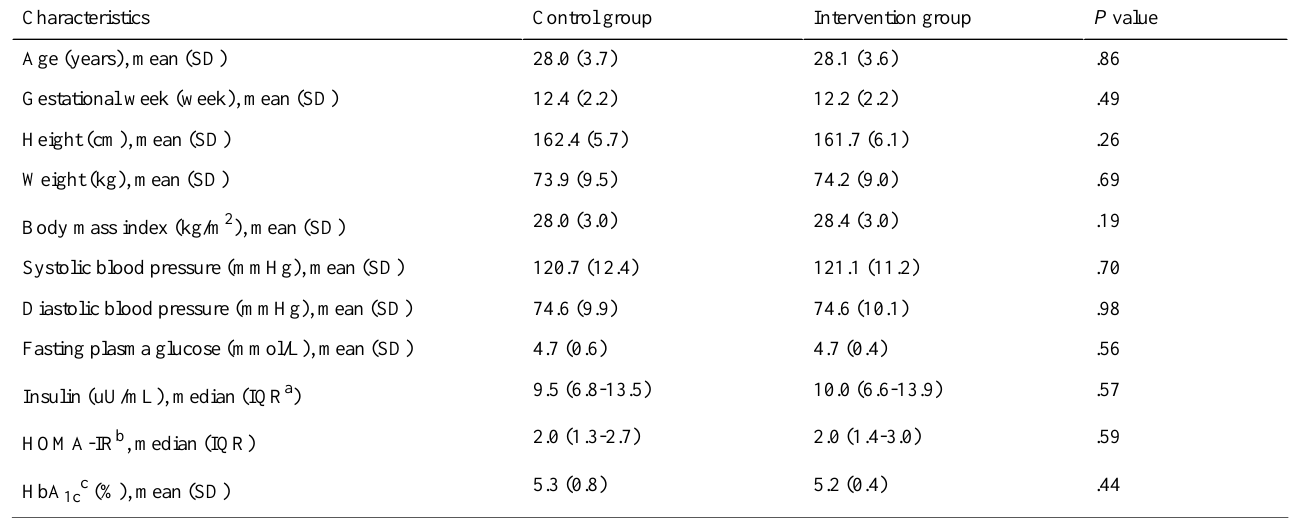
Table 1. Baseline characteristics of the study participants (N=200).